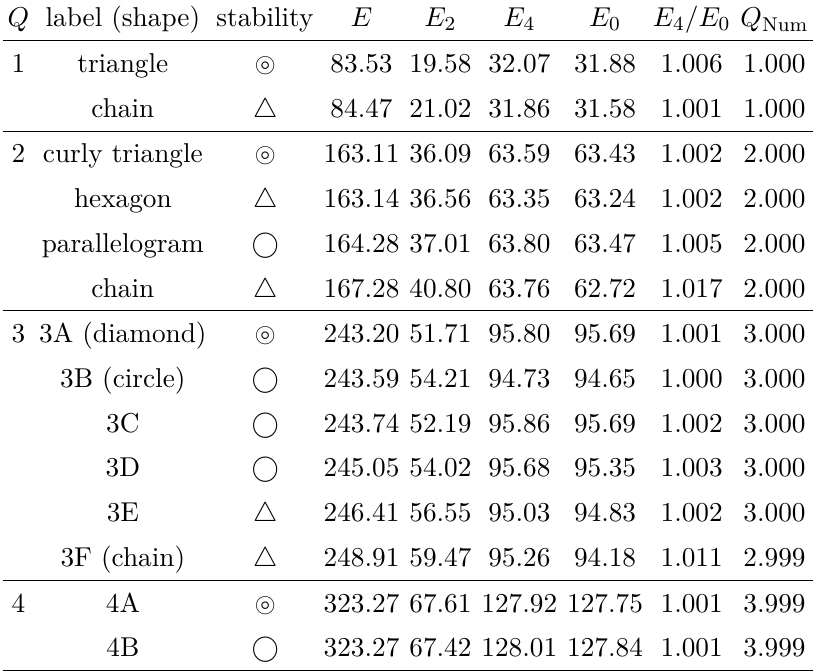
Table 1 . The numerical values of the energy and topological charge of stable ( } ), metastable ( (cid:13) ), and unstable ( 4 )